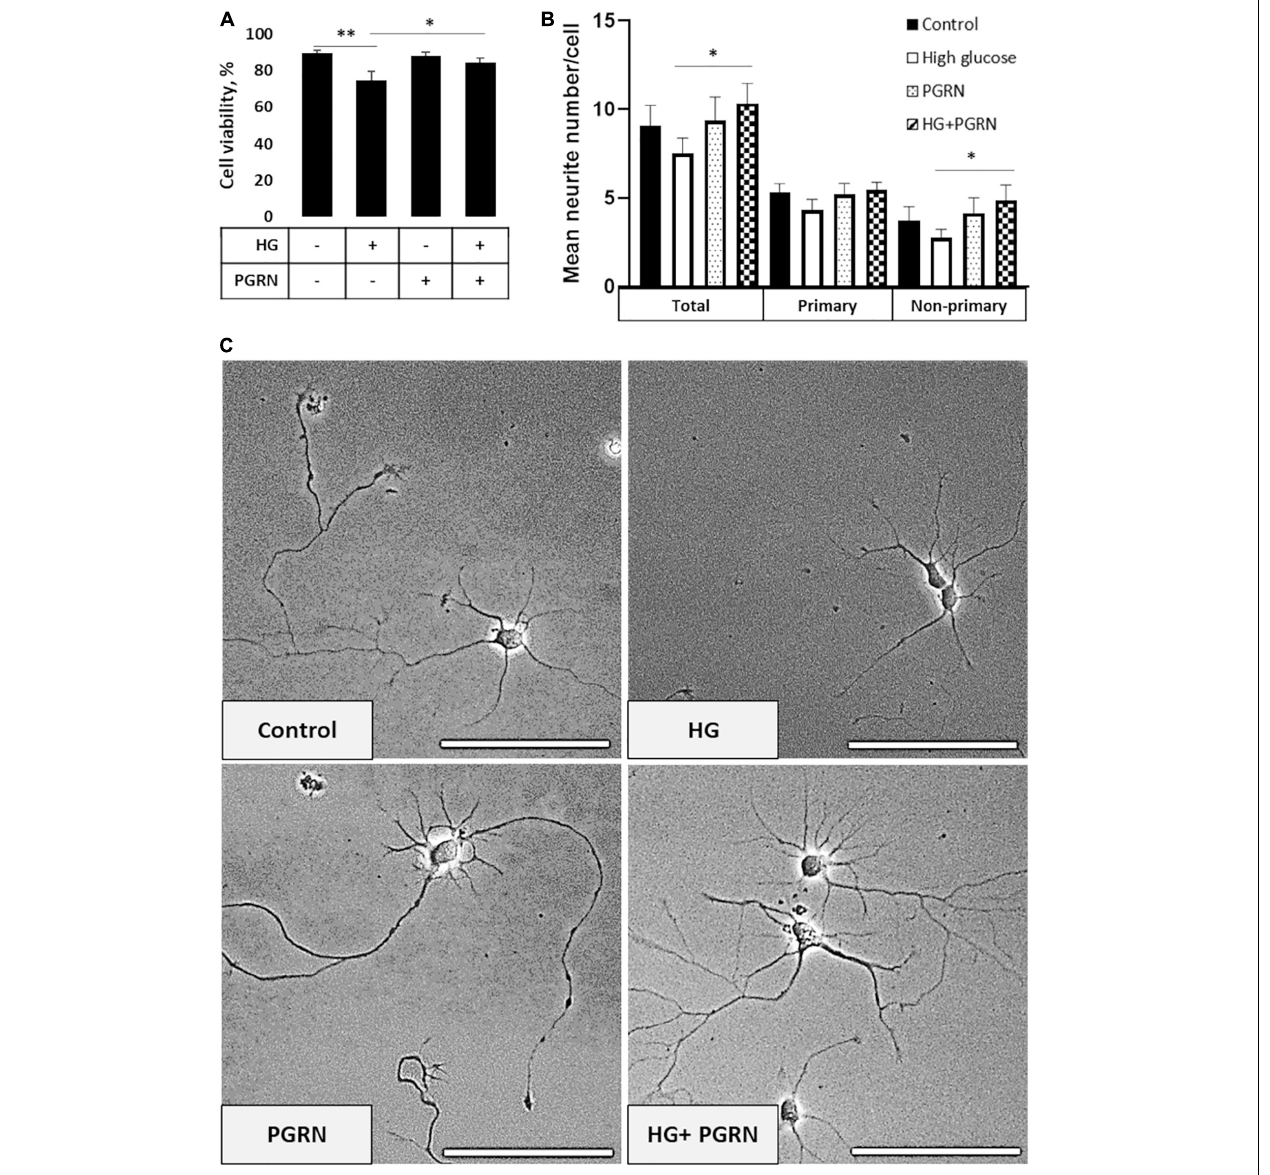
FIGURE 1 | Neuronal viability and neurite outgrowth in neurons treated with high glucose and PGRN. (A) Viability of DIV 10 cortical neurons cultured in high-glucose medium (HG) decreased after 72 h from 89.55 ± 1.27% to 74.61 ± 4.80%. PGRN treatment significantly preserved viability under high glucose, with a viability of 84.35 ± 2.29% compared to 74.61 ± 4.80% for HG alone. N = 8 fields of view (FoV). (B) Number of neurites per cell was counted at DIV 4 after 72 h of treatment using NeuronJ. High glucose lowered mean neurite count from 9.067 ± 1.181 to 7.325 ± 0.784 neurites, while PGRN increased mean neurite count from 7.325 ± 0.784 to 10.353 ± 1.019 neurites. Specifically, this increase was significant in non-primary neurites (2.765 ± 0.481 neurites to 4.882 ± 0.857 neurites) and trending toward significance in primary neurites (4.471 ± 0.438 neurites to 5.471 ± 0.444 neurites). N = 13-17 neurons. (C) Representative phase-contrast images